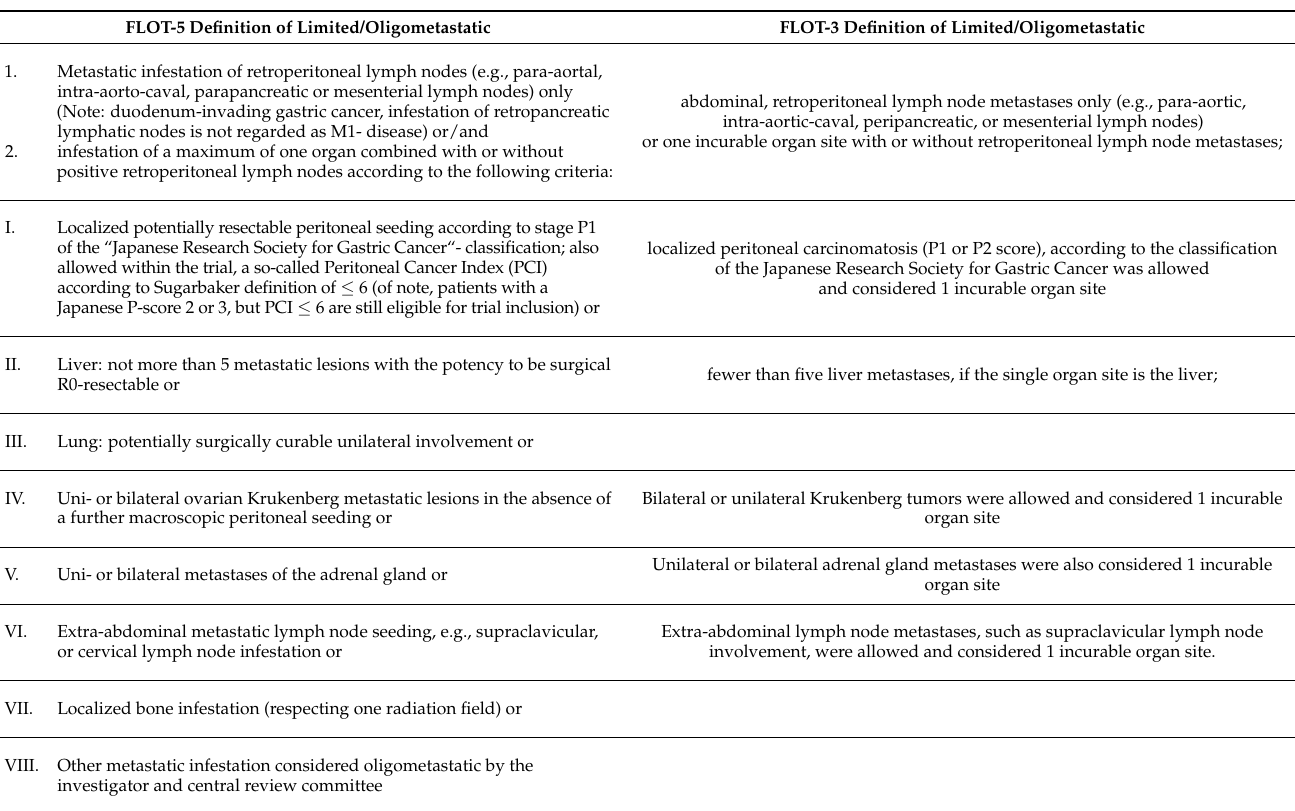
Table 1. Definition of limited/oligometastatic disease in gastroesophageal cancers according to FLOT-5 vs. FLOT-3